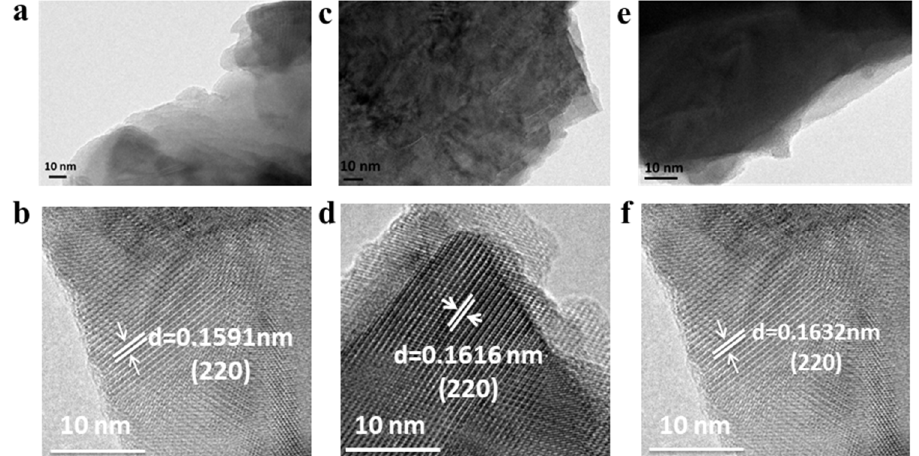
Figure 4. TEM images of CMO-8 ( a , b ); CMO-9 ( c , d ); CMO-1 ( e , f ). The surface composition and chemical states of the CoMoO 4 were further charac- terized by XPS. The full-survey-scan spectra further demonstrate the presence of Co, Mo, O, and C (Figures 5 and S1). Figure 5a shows the curves of Co 2p, which shows two obvious peaks of 2p3/2 and 2p1/2, and two satellites (marked as “Sat.”). Two low bind- ing energy peaks at 780.35 and 796.7 eV are assigned to Co 3+ , while the other peaks at 781.82 and 797.0 eV are well-matched with Co 2+ [44,45]. Figure 5b displays Mo 3d XPS doublets, which correspond to Mo 3d 5/2 and Mo 3d 3/2 . The Mo 3d doublet binding ener- gies of CoMoO 4 shift towards a lower level. The peaks at 232.2 and 235.25 eV come from the Mo 6+ [45]. As shown in Figure 5c, the peak at 530.18 eV was ascribed to the lattice oxygen (O latt ) bonds of metal oxides; the peak at 531.28 eV might be owing to the defect site of low hypoxia coordination, indicating that O vac were created on the surface of Co- MoO 4 [46]. The ratios of O latt and O vac were 77.773% and 22.227%. Figure 5d shows the C1s: the peak at 284.8 eV was ascribed to the C-C, the peak at 286.4 eV was ascribed to the C-N, and the peak at 289 eV was ascribed to the O-C=O [47]. Figure S1 shows the survey spectra. This further confirms the formation of CoMoO 4 . Figure 5. XPS spectra of ( a ) Co 2p; ( b ) Mo 3d; ( c ) O 1s; ( d ) C 1s of CMO-8. CMO-8 samples were heated from 40 ◦ C to 800 ◦ C under an air/N 2 flow of 20 mL/min, and the heating rates were 10 ◦ C/min. In order to eliminate systematic error, blank tests were performed before the experiment to provide the baseline, and repetitions were also performed to ensure good reproducibility of the results. Figure 6a,b shows the TGA and DTG curves of CMO-8 at 10 ◦ C/min, with the 0.23682% and the 0.36296% of weightlessness in air and N 2 atmosphere, respectively. The CMO-8 sample exhibits excellent thermal stability in both air and N 2 atmospheres due to its negligible mass